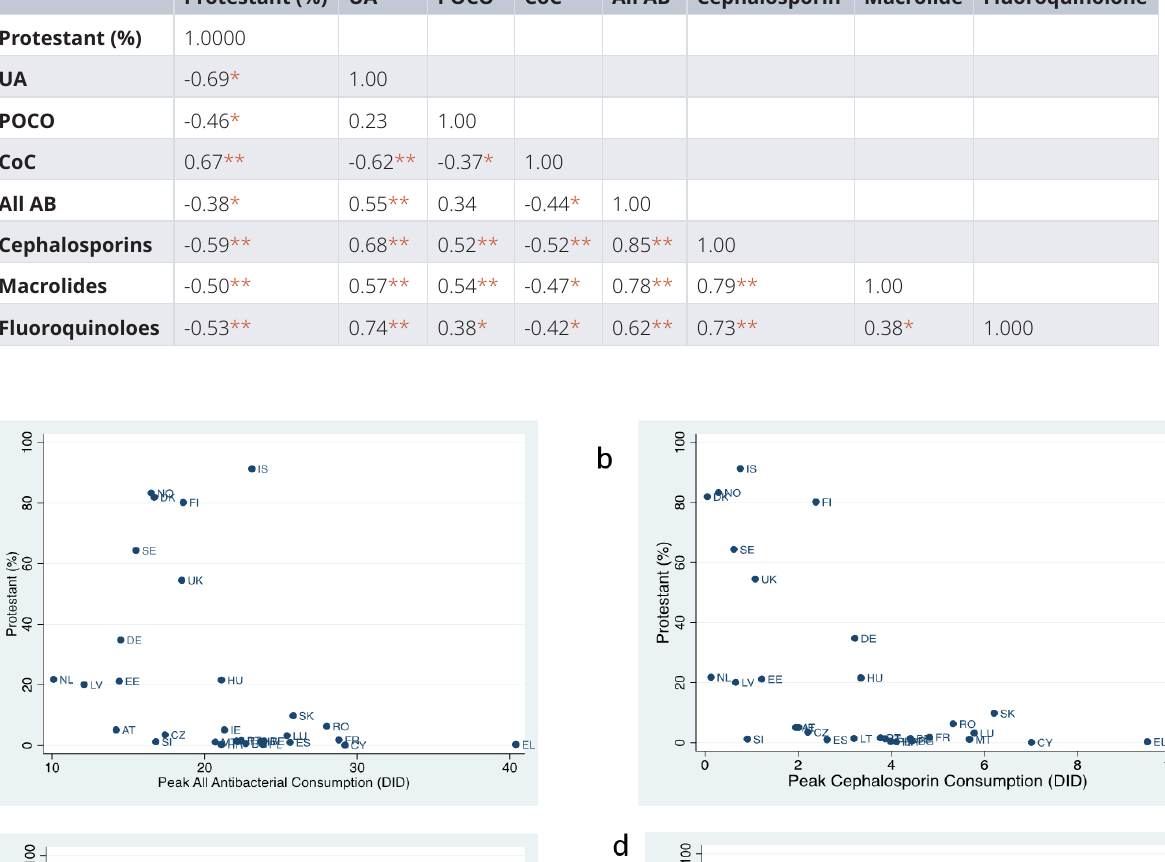
types of antimicrobial resistance 27 . Our sample size was also too small to justify controlling for a large range of confounders. There are a number of fundamental problems with